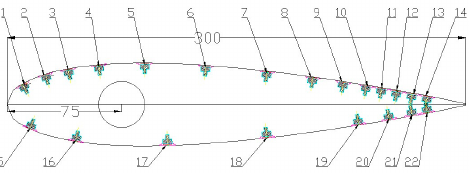
Figure 4. Schematic diagram of the chordal installation position of pressure sensors. Table 3. Chord-wise installation position of pressure sensors.